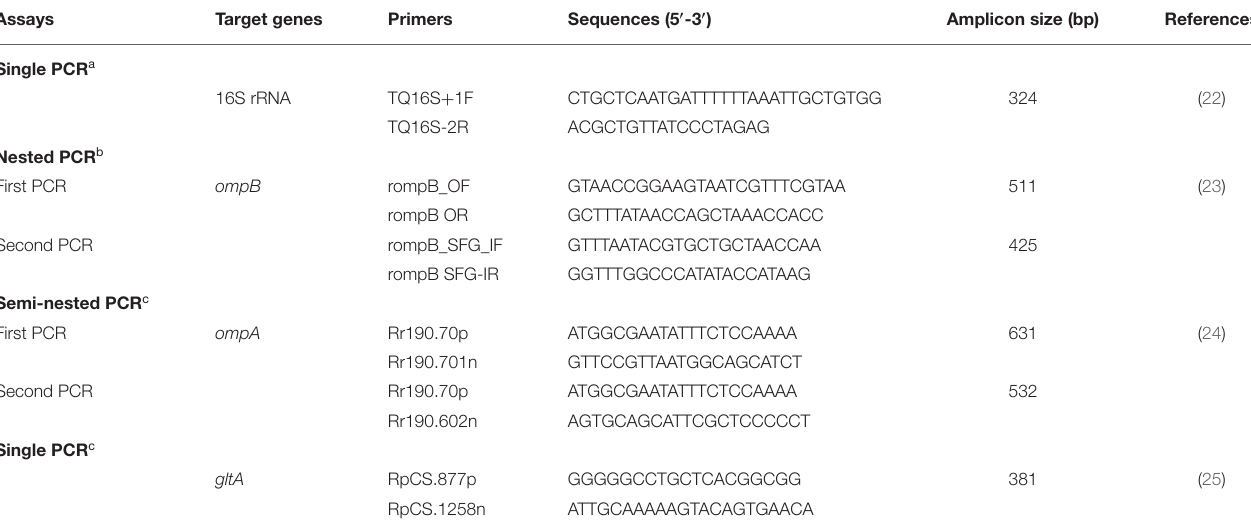
TABLE 1 | Primers used for the identification and/or genetic characterization of Rickettsia species infecting ticks collected in this study from small ruminants. Assays Target genes Primers Sequences (5 ′ -3 ′ ) Amplicon size